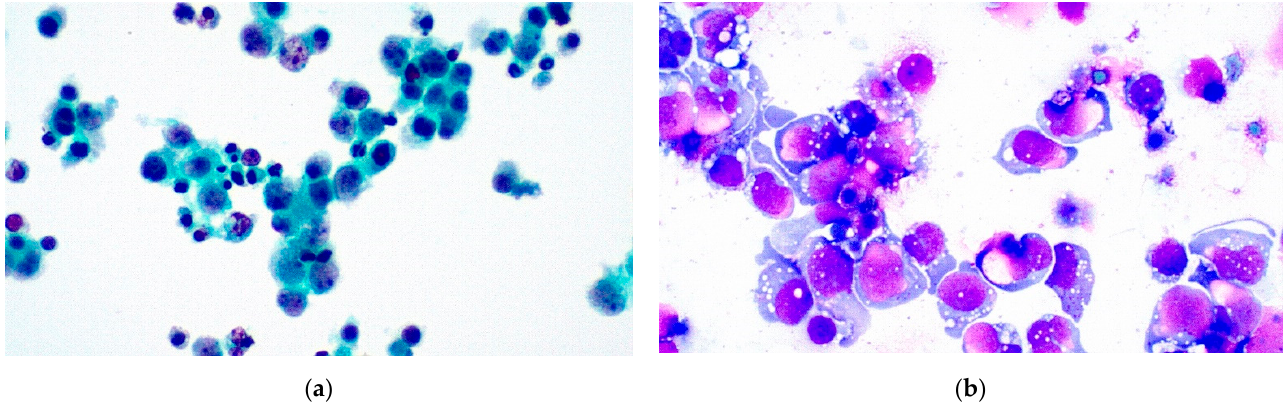
Figure 2. Pleural effusion MAL (TIS5) diffuse large B-cell lymphoma (DLBCL). ( a ) Pap stain ×200 and ( b ) Giemsa stain ×400.